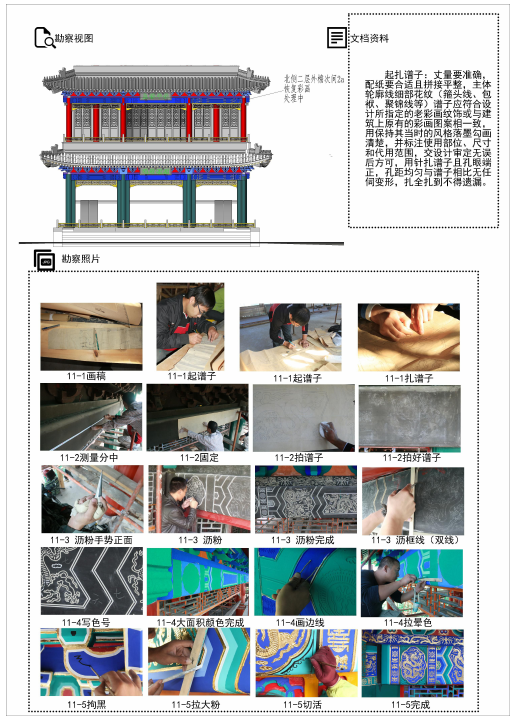
Figure 12. Survey